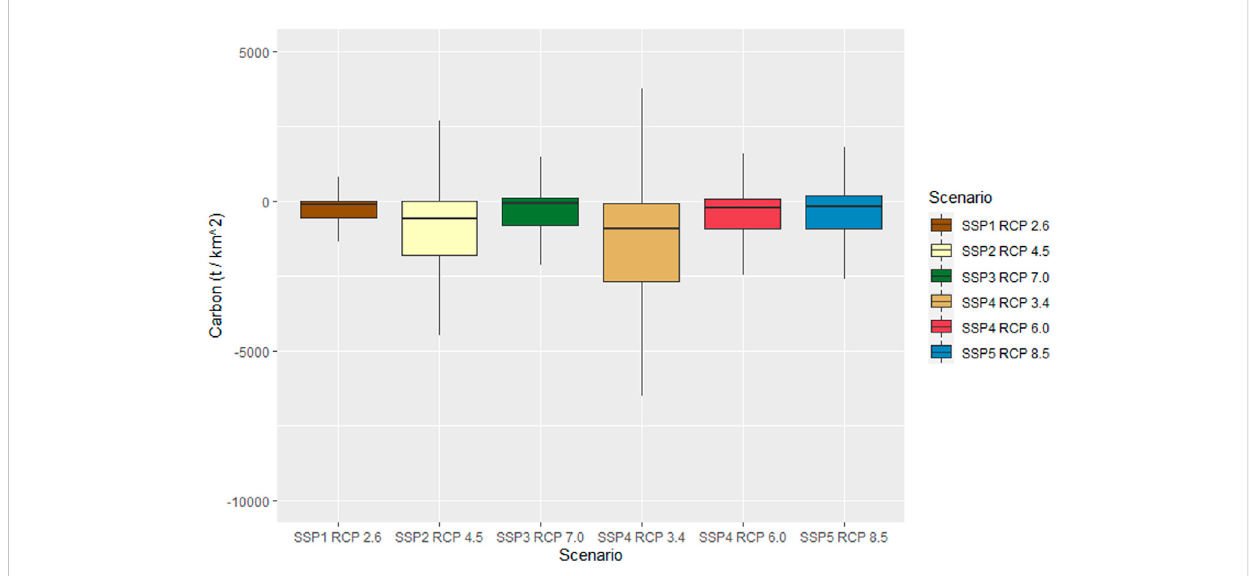
Box plot representing the spread of carbon change (t) for the SEA urban clusters normalized with their respective size (km 2 ) for the SSP scenarios.